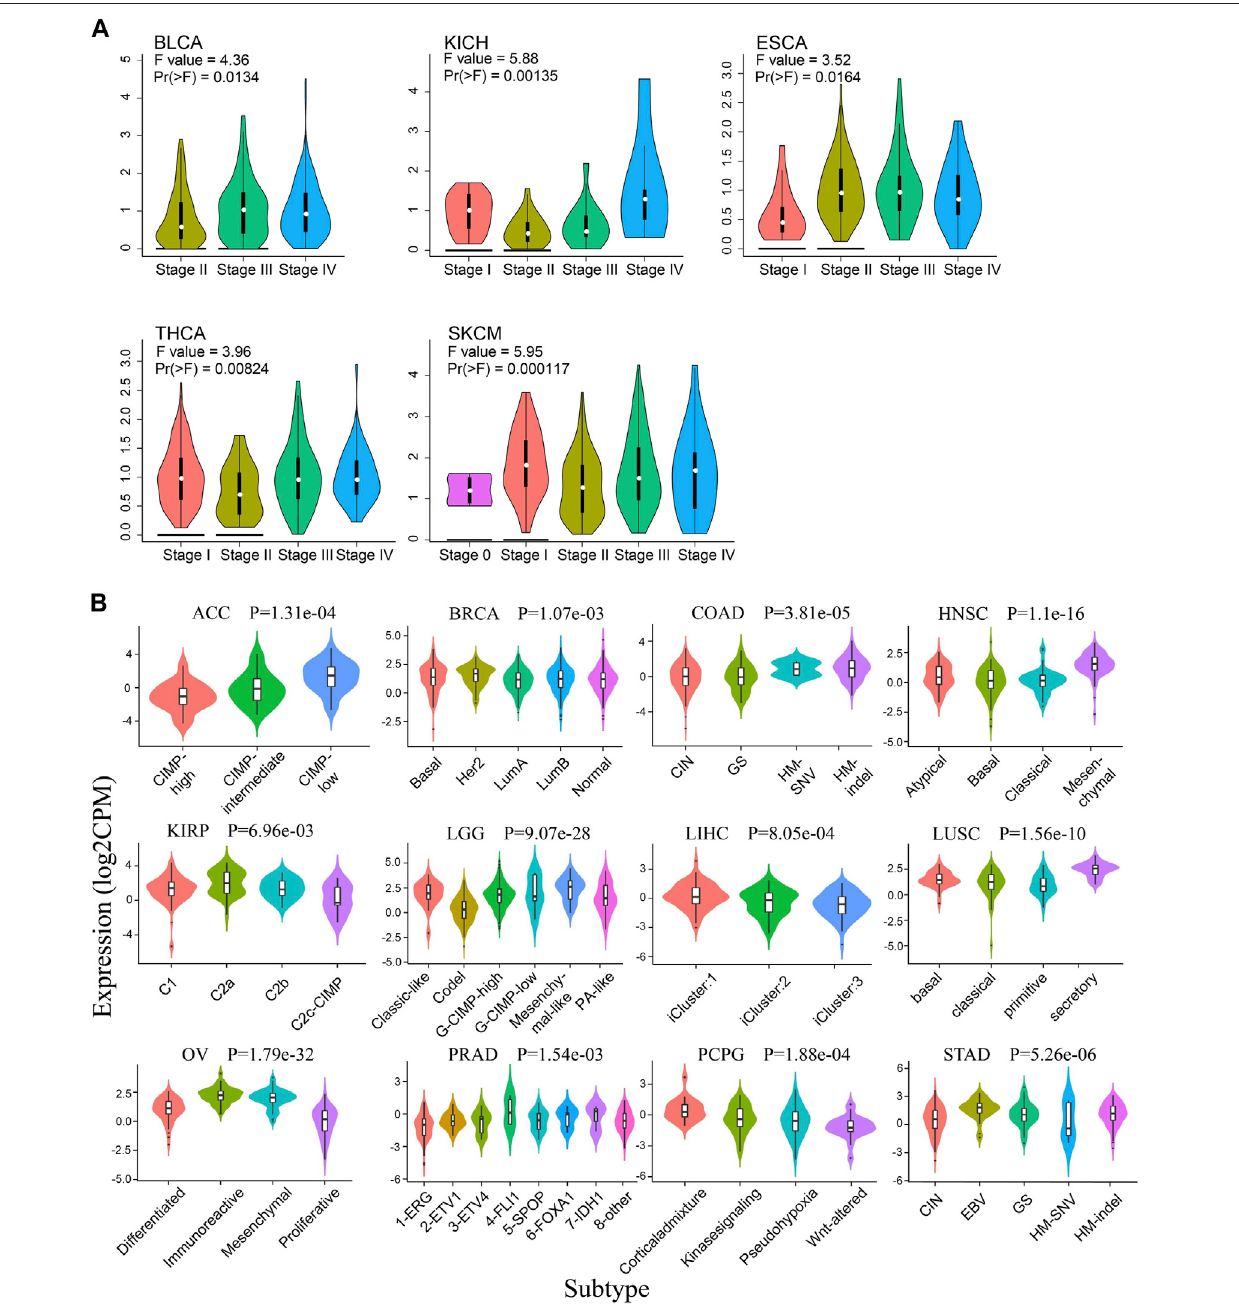
FIGURE2| ThecorrelationbetweenSiglec-9mRNAexpressionandtumorstagesandmolecularsubtypes. (A) ThecorrelationbetweenSiglec-9expressionandtumor stageinvariouscancersobtainedfromGeneExpressionPro fi lingInteractiveAnalysis2.0(GEPIA2.0).Tumorswithasigni fi cantresultwereshown. [Verticalaxis:log2(TPM+ 1); one-way ANOVA, Pr ( > F) < 0.05 was considered to be signi fi cant. The larger the F value and the smaller the Pr ( > F) value, the greater the difference in characteristics between groups.] (B) The correlation between Siglec-9 expression and different molecular subtypes from Integrated Repository Portal For Tumor-Immune